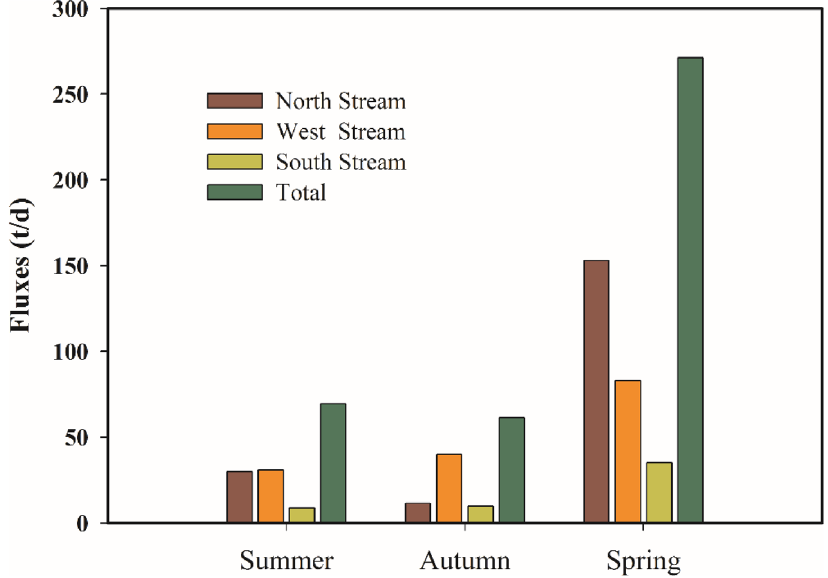
Figure 5. Seasonal variation in TOC fluxes into estuaries for different streams. The figure was prepared using Sigma-Plot Version 10.0 (Systat Software, Inc., San Jose, California, USA).